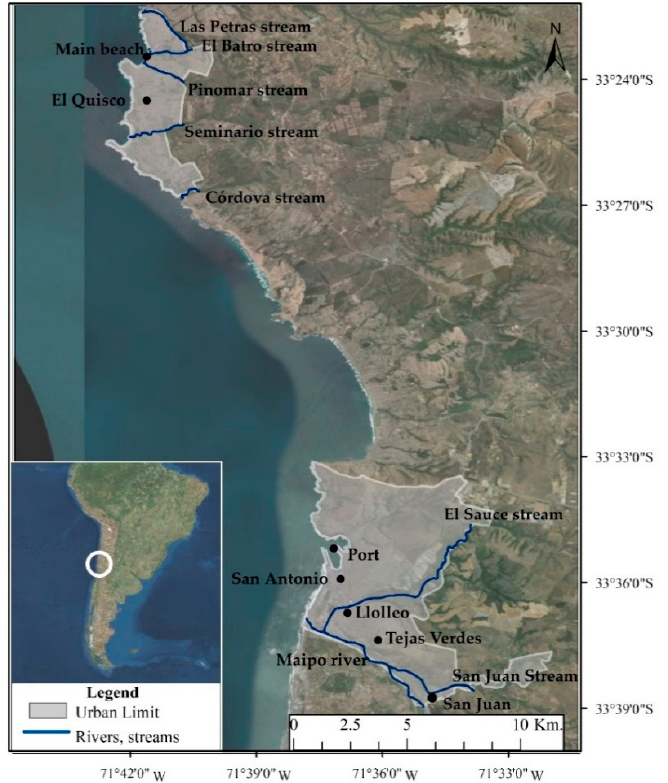
Figure 1. Location of El Quisco and San Antonio. Rivers and streams are presented in blue lines .